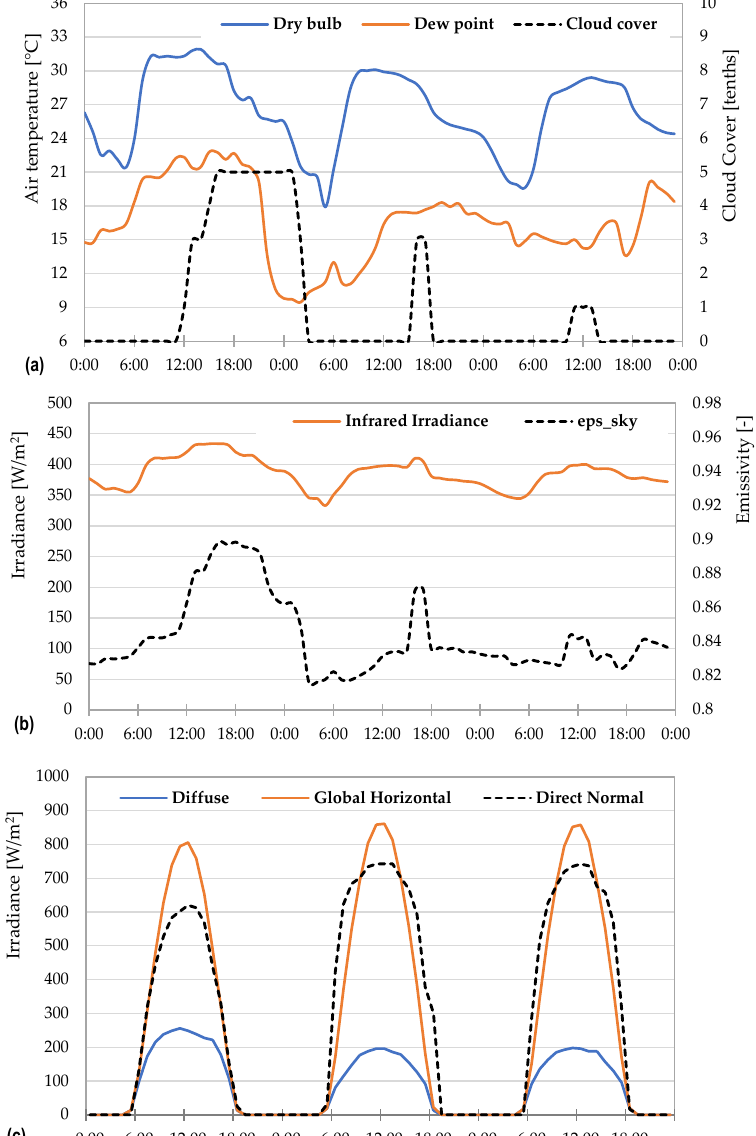
Figure 11. Time trend of some weather variables (21–23 August 2019, TMY typical year). ( a ) Input data to calculate the horizontal infrared sky irradiance; ( b ) sky emissivity and horizontal infrared sky irradiance; ( c ) components of the solar irradiance. Table 8. Heating and cooling energy needs according to the different weather datasets.